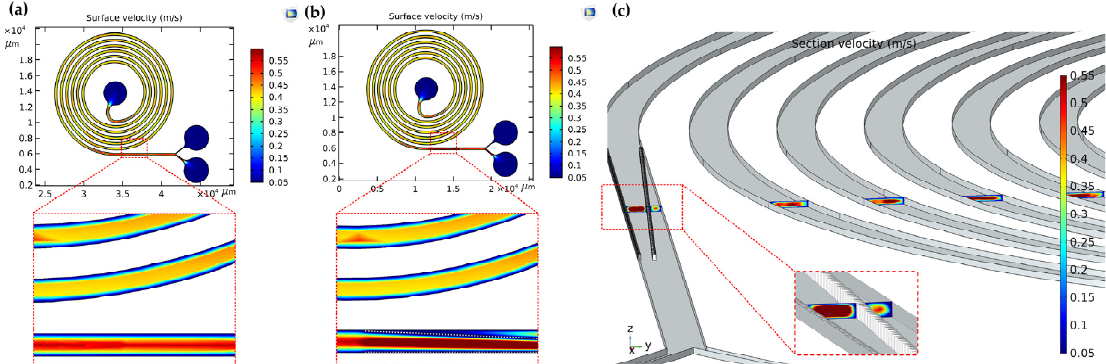
Figure 5. ( a ) The surface velocity distributions in the micropillar-free channel; ( b ) The surface velocity distributions in the micropillar channel; ( c ) The section velocity distributions of each return section in the micropillar